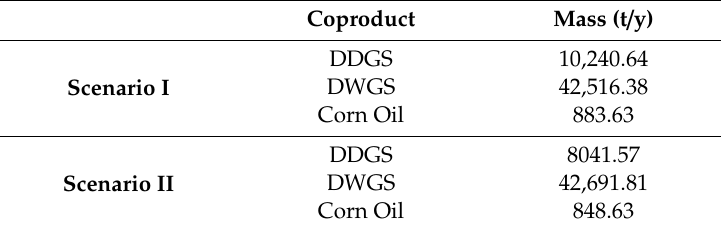
Figure 5. Proportion of annual utility costs for Scenario I (evaporation process) and Scenario II (flocculation process).